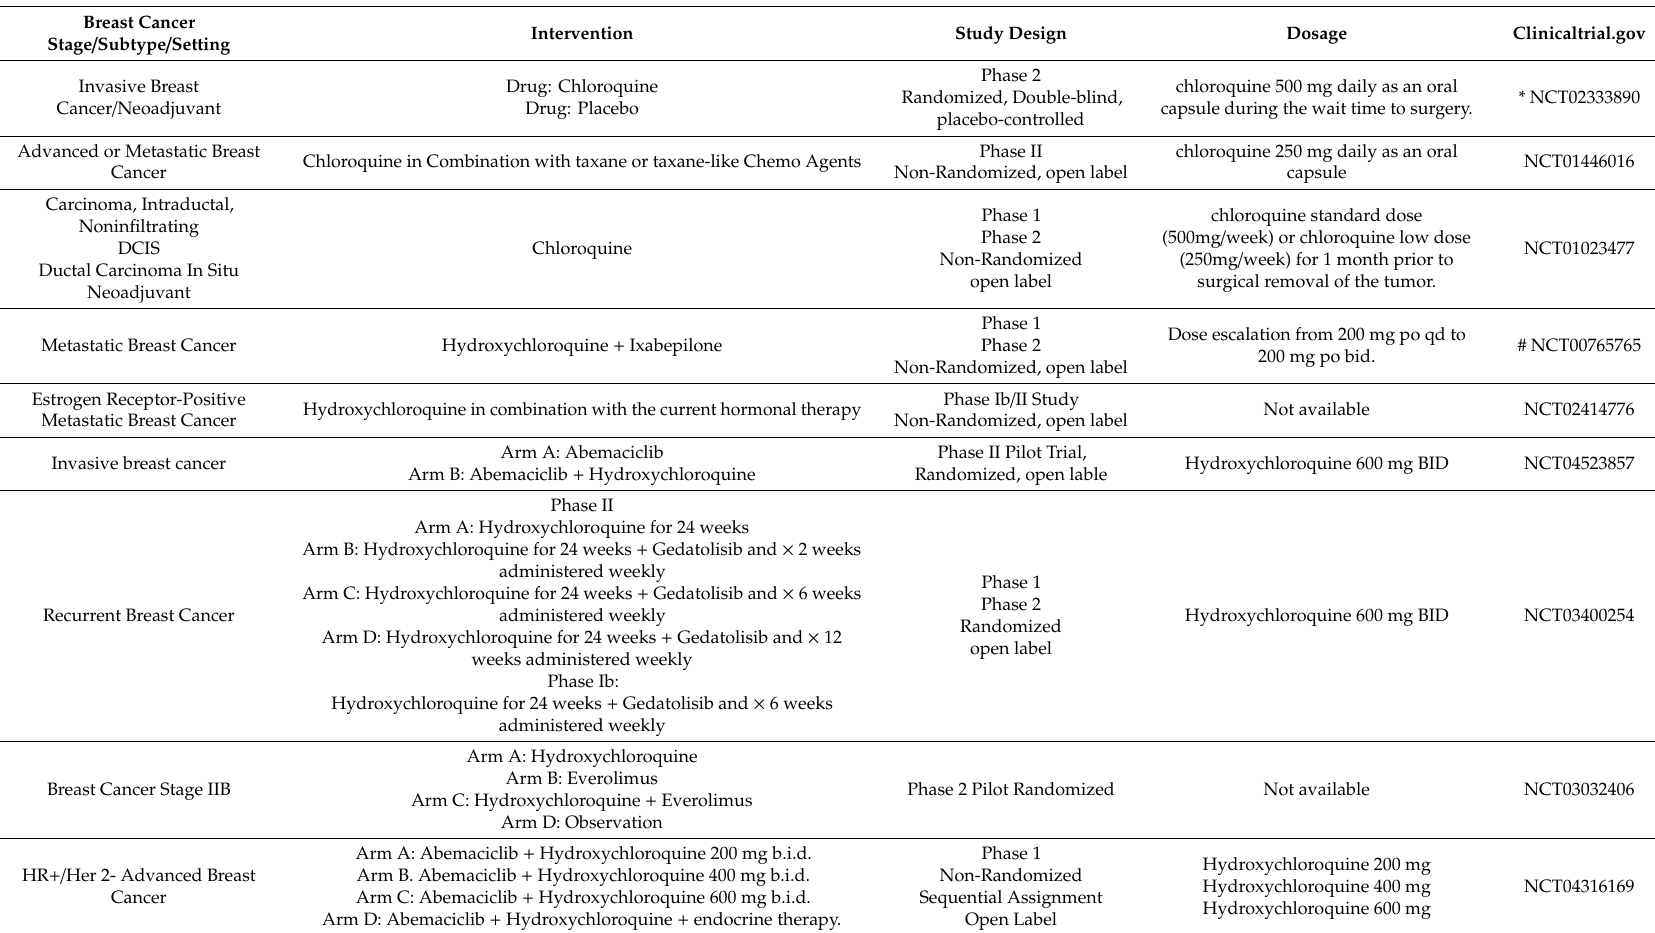
Table 1. Clinical trials in breast cancer with Chloroquine or Hydroxychloroquine by clinicaltrial.gov website. Breast Cancer Intervention Dosage Stage / Subtype / Setting